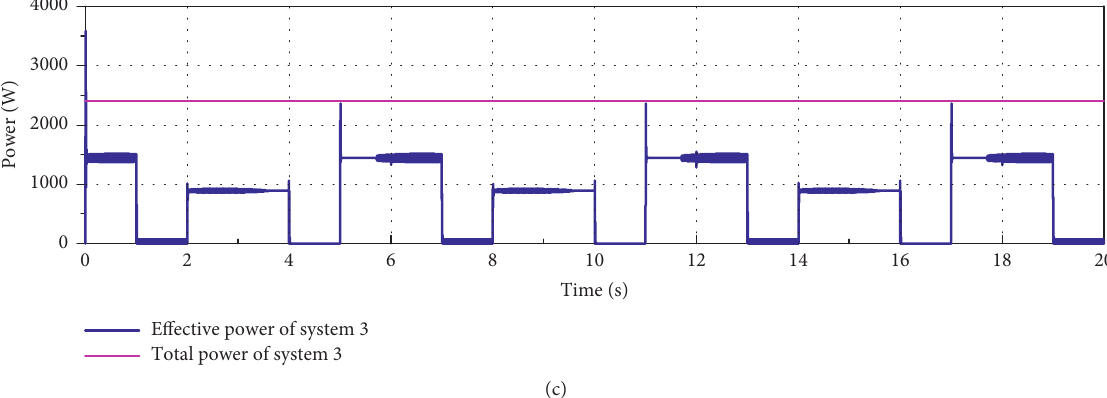
Figure 22: The power of the three systems in test 2.